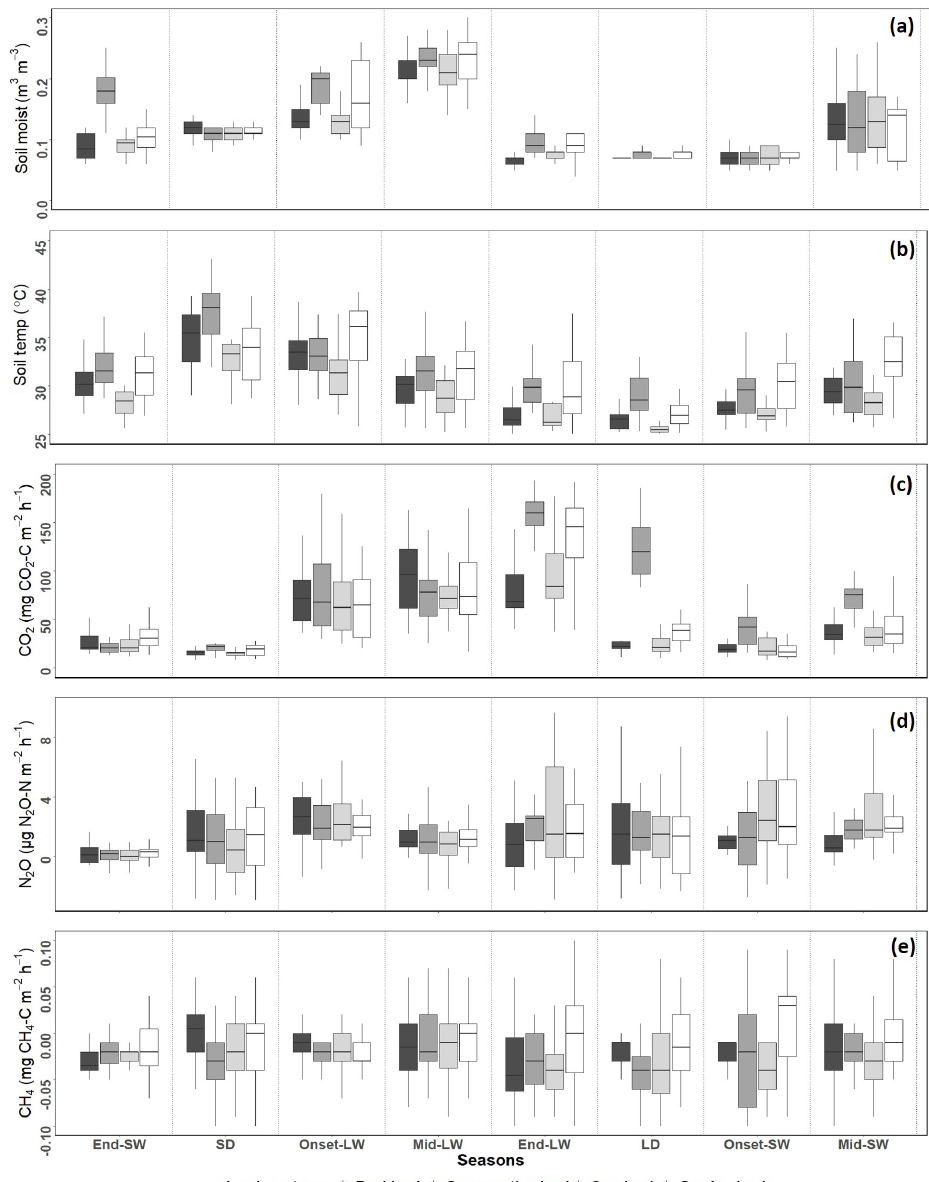
Figure 4. Box plots showing differences in seasonal means for (a) soil moisture and (b) soil temperature and for soil emissions of (c) CO 2 , (d) N 2 O, and (e) CH 4 for each site from November 2017 to October 2018. Season abbreviations on the x axis are SW for the short wet season and LW for the long wet season, with onset, middle (mid) and end of the corresponding wet season also shown, along with SD for the short dry season and LD for the long dry